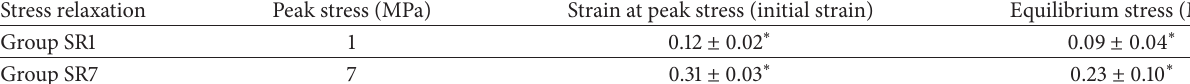
Table 1: Average values obtained from stress relaxation tests. Asterisks indicate significant differences ( 𝑝 < 0.05 ).